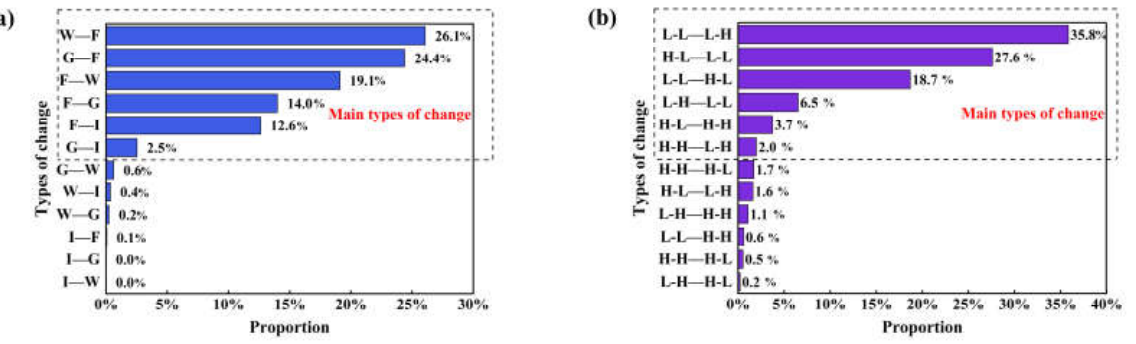
Figure 11. ( a ) Types of change of land-use types and ( b ) spatial matching pattern of supply and demand; W is for woodland, G is for grassland, F is for farmland, and I is for impervious surface.